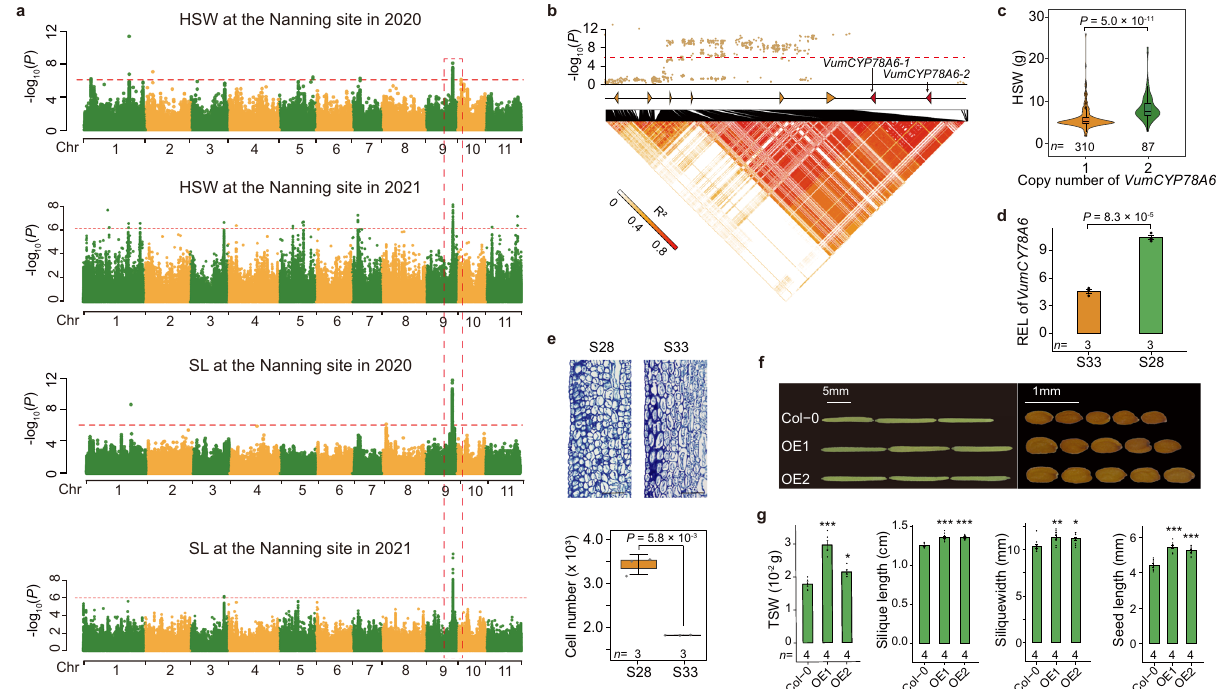
Fig.6|Tandemduplicationofthe VumCYP78A6 geneassociatedwithseedyield traits. a GWAS using the 2020 and 2021 Nanning datasets, indicating that the strongest association signals for hundred seed weight (HSW) and seed length (SL) traits all located at Chr9: 29,030,437 – 29,126,729. b Local Manhattan plot of HSW (top), the gene models (middle), and pairwise linkage disequilibrium heat map (bottom) at Chr9: 29,030,437 – 29,174,247. The two tandemly duplicated Vum- CYP78A6 genes( VumCYP78A6-1 and VumCYP78A6-2 )areshownwiththereddashed triangles. In a and b , the red horizontal dashed lines indicated the Bonferroni- corrected signi fi cance thresholds of GWAS ( α =1). c The HSW distributions of landraces carrying distinct copy numbers of the VumCYP78A6 gene. The number ( n )oflandracescarryingdistinctcopynumbersisshownbelow. d Barplotshowing the relative expression levels of VumCYP78A6 in the pods at 16 DAP (days after pollination) from the long-seed landrace S28 (carrying two gene copies) and the short-seedlandraceS33(carryingonegenecopy). e Lightmicroscopeimages(top)